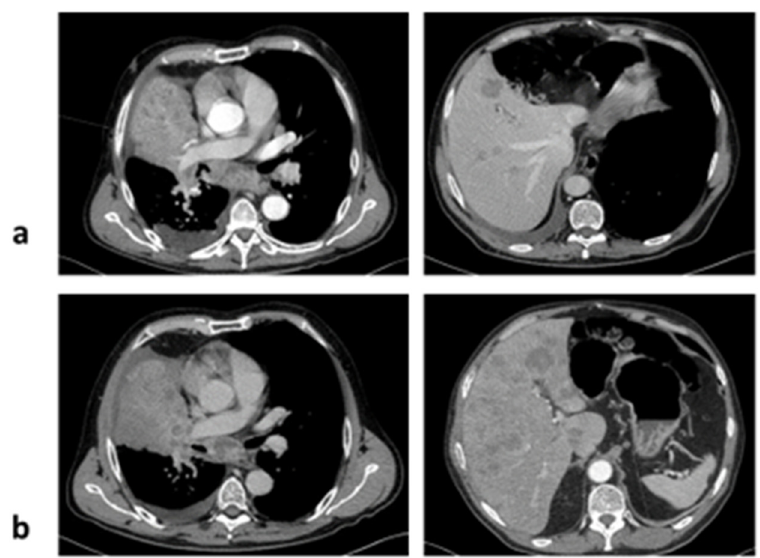
Figure 2. Computer tomography scans: ( a ) at baseline, and ( b ) at disease progression after two cycles of pembrolizumab.